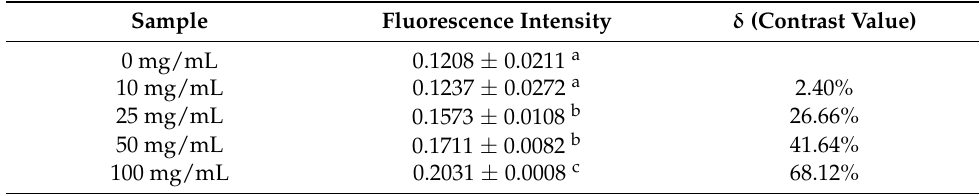
Table 2. Results of cell fluorescence intensity .